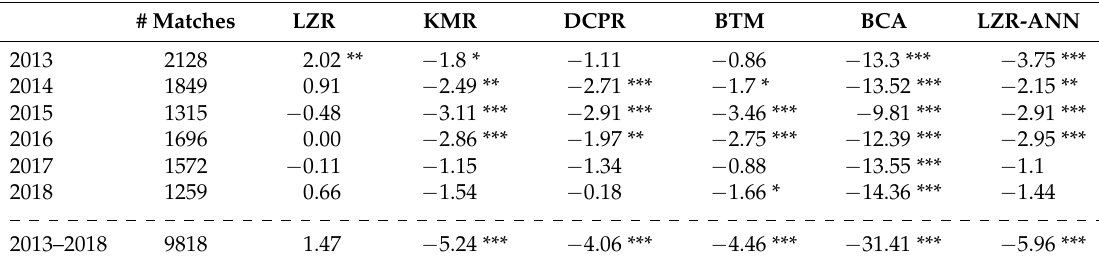
Table 2. ANN evaluation with the Diebold–Mariano